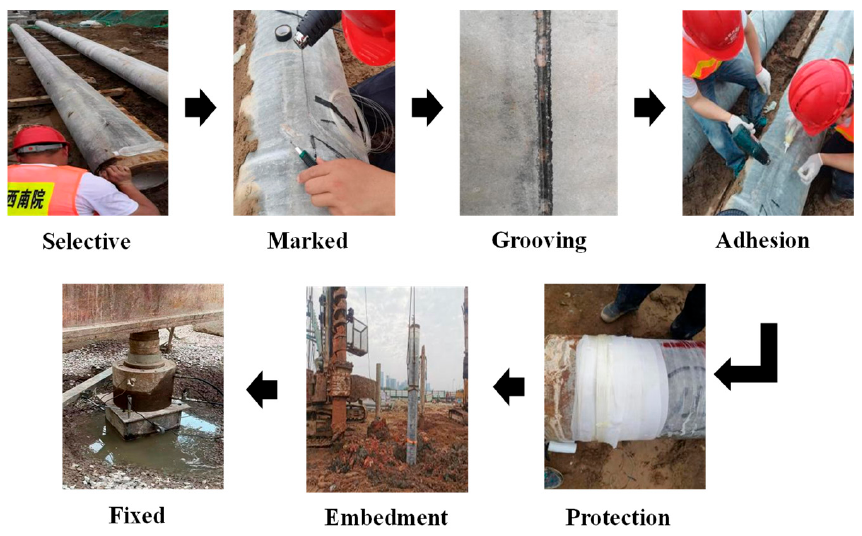
Figure 2. Single pile test layout procedure.